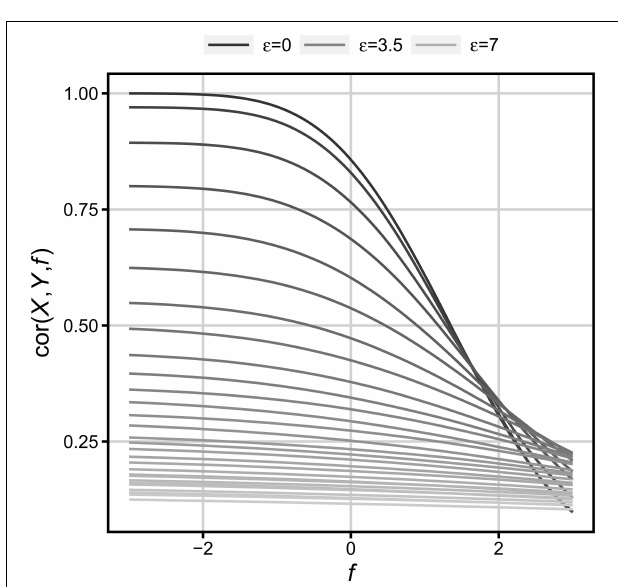
FIGURE 4 | Change in correlation over floor and error. The error value differs from zero (the darkest highest line) to five standard deviations of X (the lightest lowest